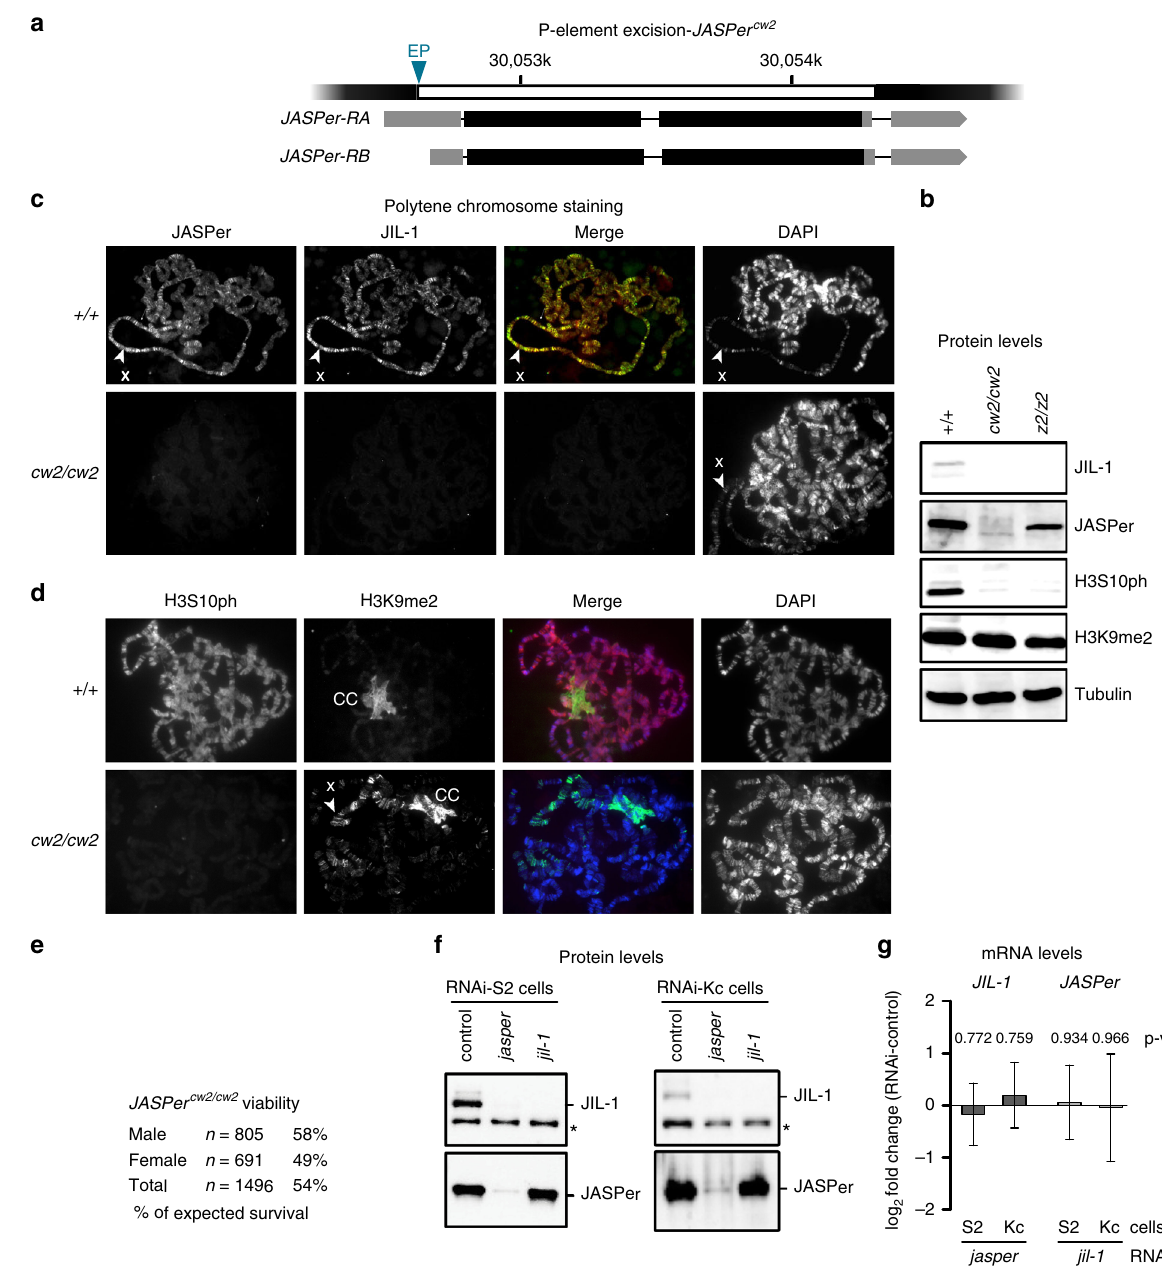
Fig. 2 JIL-1 is unstable in absence of JASPer in the JASPer cw2/cw2 mutant and in cell lines. a Gene model for P-element excision in the JASPer locus to generate JASPer cw2 allele. The mRNA isoforms RA and RB are shown below. The excised genomic portion is marked in white and EP denotes the position of the excised P-element in EP-element line GS3268. b Western blot analysis of salivary gland extracts from L3 larvae of homozygous JASPer cw2/cw2 and JIL- 1 z2/z2 mutants and wild type larvae as control. Western blots using α -JIL-1, α -JASPer, α -H3S10ph, and α -H3K9me2 antibodies are shown, western blot with α -tubulin antibody was used as loading control. c Immuno fl uorescence microscopy of polytene chromosome squashes from L3 larvae of homozygous JASPer cw2/cw2 and wild type larvae as control. From left to right, staining for JASPer, JIL-1, merged images and DNA are shown. The X chromosome is marked by arrow heads. Source data are provided as a Source Data fi le. d Immuno fl uorescence microscopy of polytene chromosome spreads from L3 larvae of homozygous JASPer cw2/cw2 and wild type larvae as control. From left to right, staining for H3S10ph, H3K9me2, merged images and DNA are shown. The X chromosome is marked by arrow head and the chromocenter is labeled with “ CC ” . e Table summarizing viability of male and female JASPer cw2/cw2 mutant fl ies. f Representative western blot analysis using α -JASPer and α -JIL-1 antibodies on whole cell extracts from S2 cells (left panel) and Kc cells (right panel) after jasper or jil-1 RNAi treatment, as used for RNA-seq experiments. A cross-reacting band is marked by asterisk. Source data are provided as a Source Data fi le. g Bar chart showing mean log 2 fold-change of normalized mean RNA-seq counts for JIL-1 and JASPer RNAi. Left panel, JIL-1 mRNA mean log 2 fold-change upon jasper RNAi (S2 n = 4 and Kc n = 4). Right panel, JASPer mRNA mean log 2 fold-change upon jil-1 RNAi (S2 n = 5 and Kc n = 4). Error bars represent standard error of the